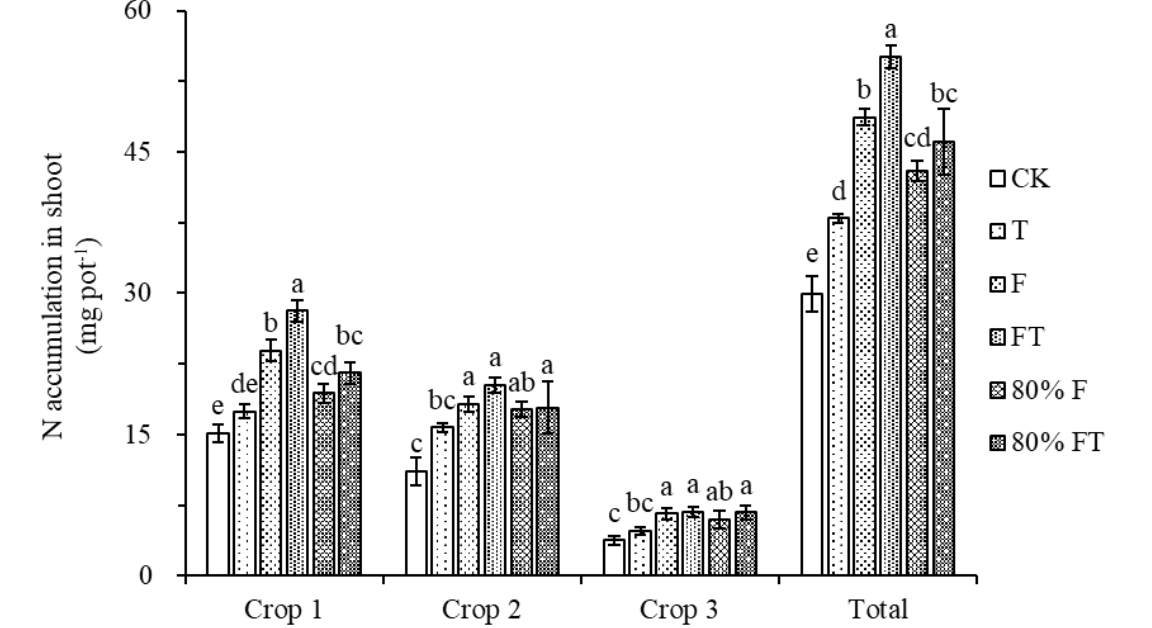
Figure 3. Effect of the preparation on nitrogen accumulation in the shoots. Values were expressed as means (n = 4) ± SE. Different letters within the same crop indicate significance at the 5% level.